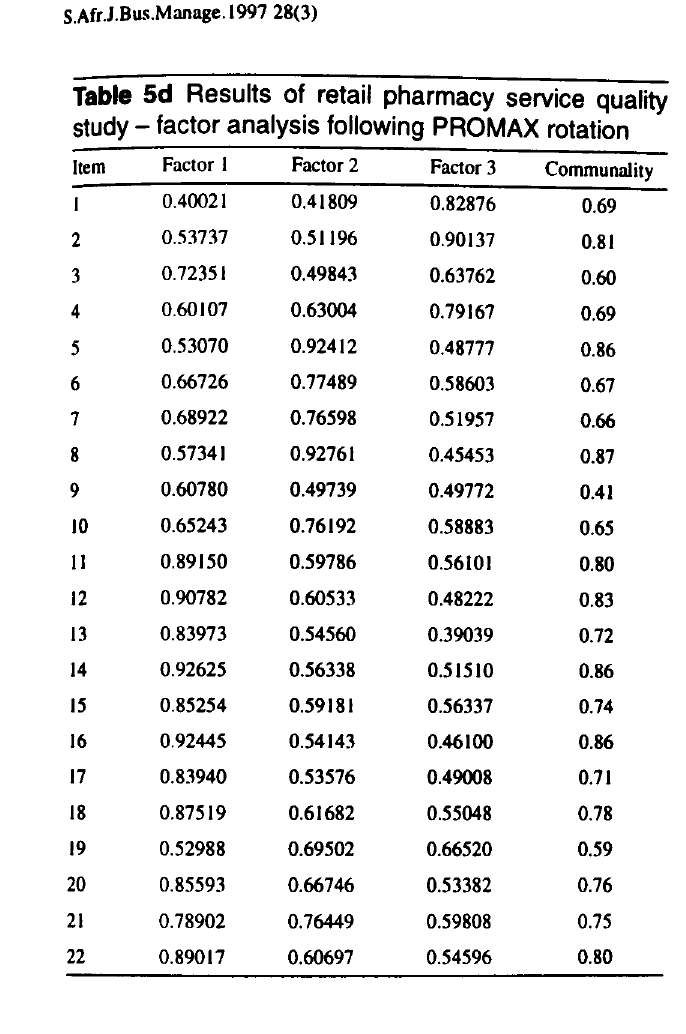
Table Sd Results of retail pharmacy service quality study - factor analysis following PROMAX rotation